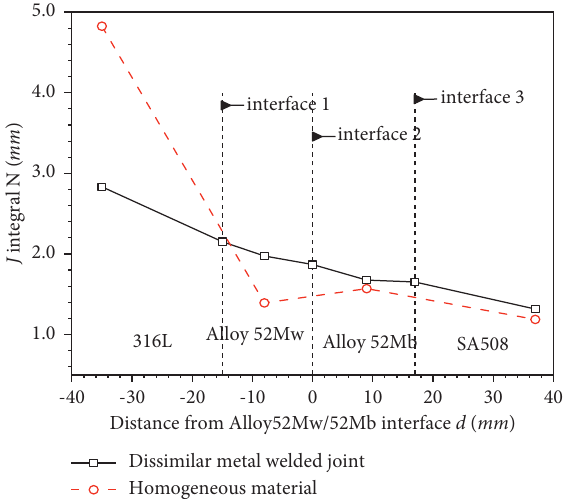
Figure 13: J -integral of the crack tip of the welded